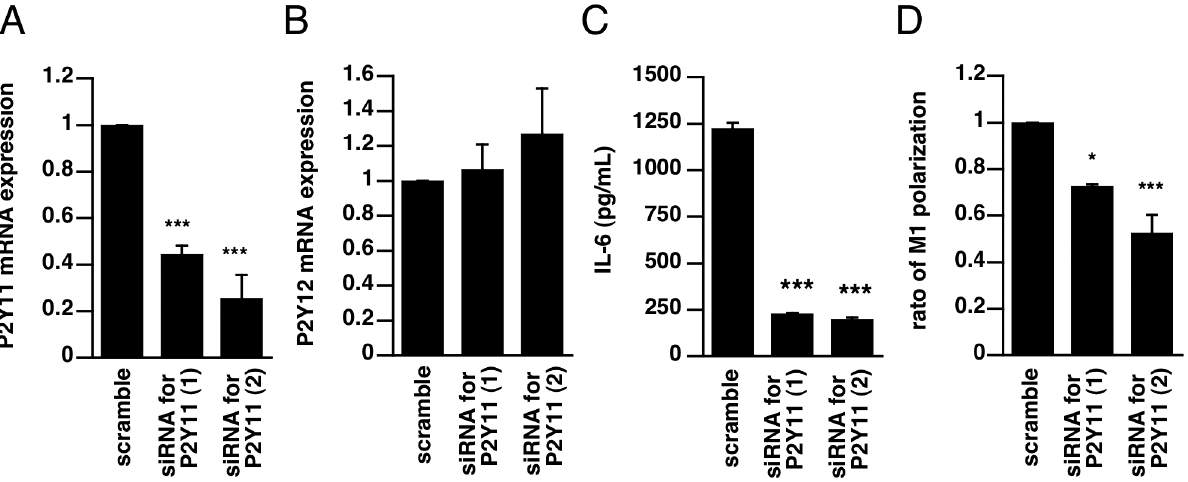
Figure 6. P2Y11 receptor is involved in IL-6 production and M1 macrophage polarization in THP-1 cells. ( A–B ) THP-1 cells were transfected with 3 m g of shRNA targeting P2Y11 (No.1 or No.2) or scramble shRNA. Twenty-four hours after transfection, total RNA was extracted and P2Y11 or P2Y12 gene expression was examined by assessing mRNA levels using real-time PCR. ( C , D ) Cells were transfected with siRNA targeting P2Y11 (No.1 or No.2) or scramble siRNA and incubated for 72 h. ( C ) The transfected cells were stimulated with LPS (10 m g/mL) and incubated for 24 h, and then the concentration of IL-6 in culture medium was measured by ELISA. ( D ) The transfected cells were cultured for 24 h in medium or in medium supplemented with LPS and IFN-gamma. Expression of M1 macrophage marker CCR7 was measured by flow cytometry. Each value represents the mean 6 SE (n=4–8). Significant differences between a test group and control group (scramble) are indicated by *(p , 0.05) and ***(p , 0.001),